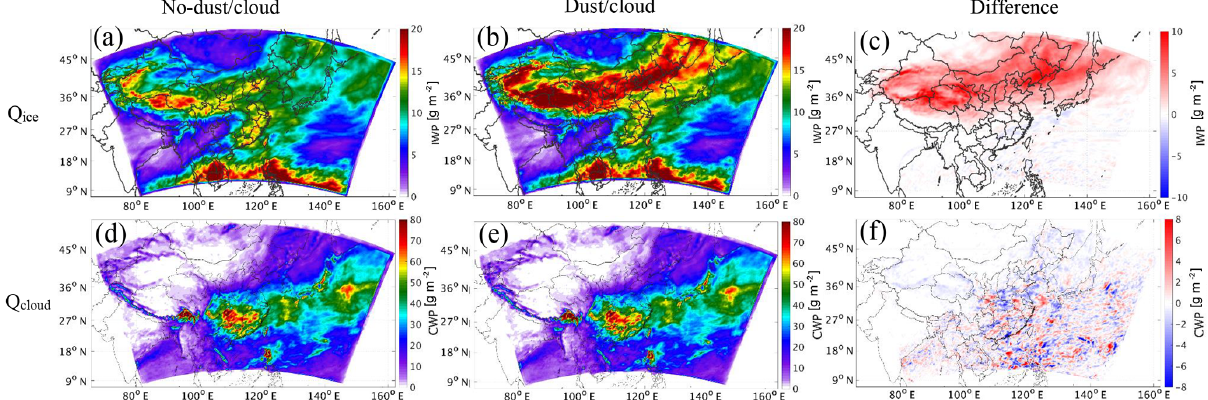
Figure 5. Spatial distributions of the average simulated IWP (a–c) and CWP (d–f) from NO-DUST/CLOUD (left panels), DUST/CLOUD (middle panels), and the difference between DUST/CLOUD and NO-DUST/CLOUD (right